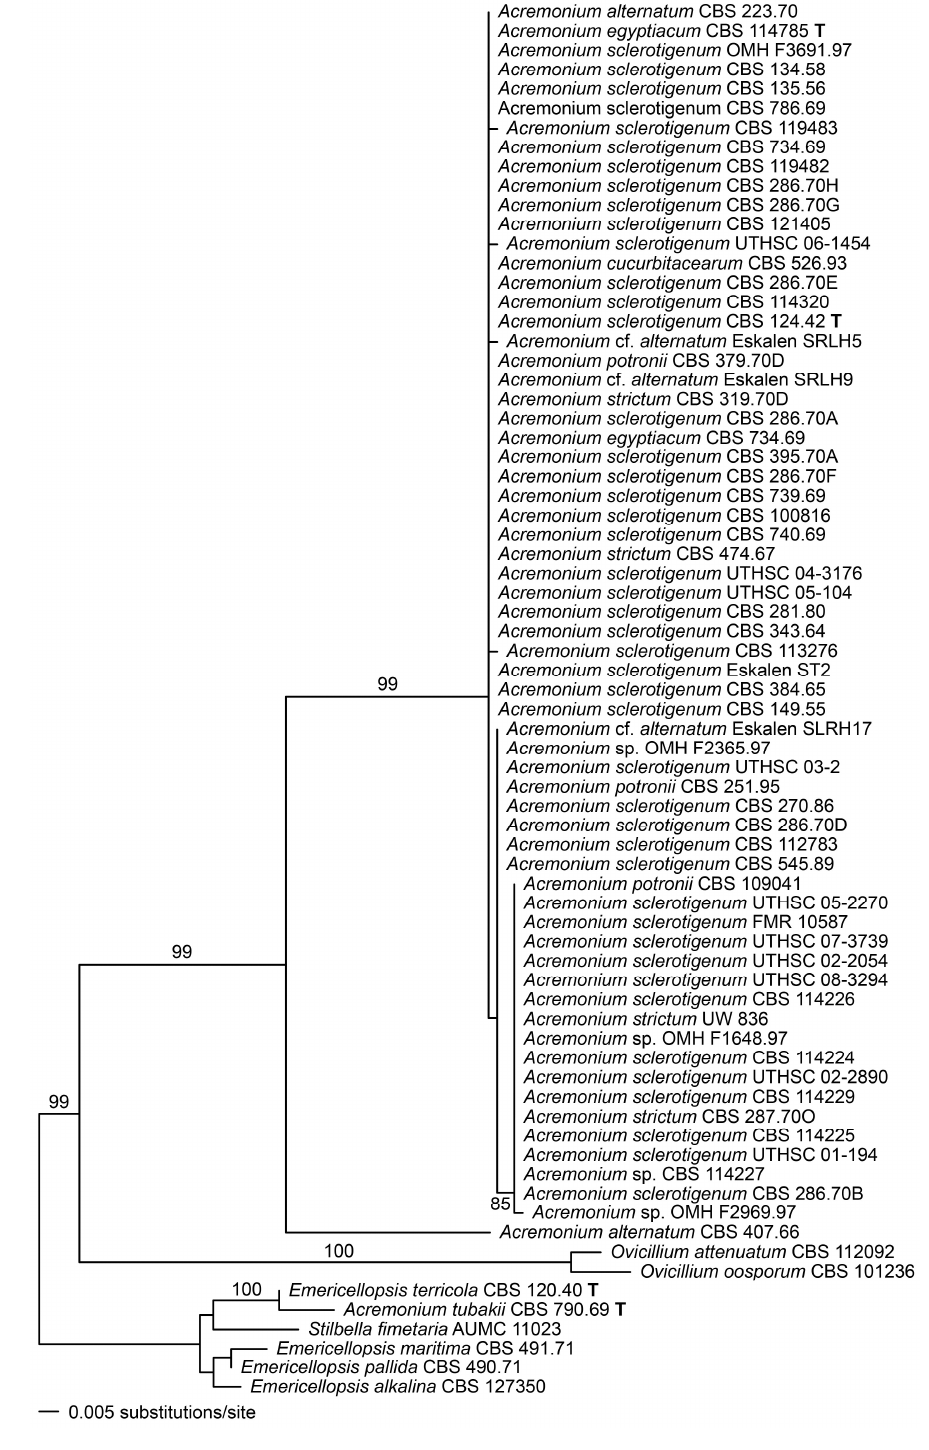
Figure 2. Phylogenetic disposition of the Acremonium sclerotigenum/egyptiacum complex as shown by complete ribosomal internal transcribed spacer (ITS) sequences analysed using maximum likelihood (ML) with RAxML VI-HPC. Support values were obtained using a fast bootstrap analysis of 1000 pseudoreplicates. Members of the Emericellopsis-Stilbella complex are used as an outgroup.